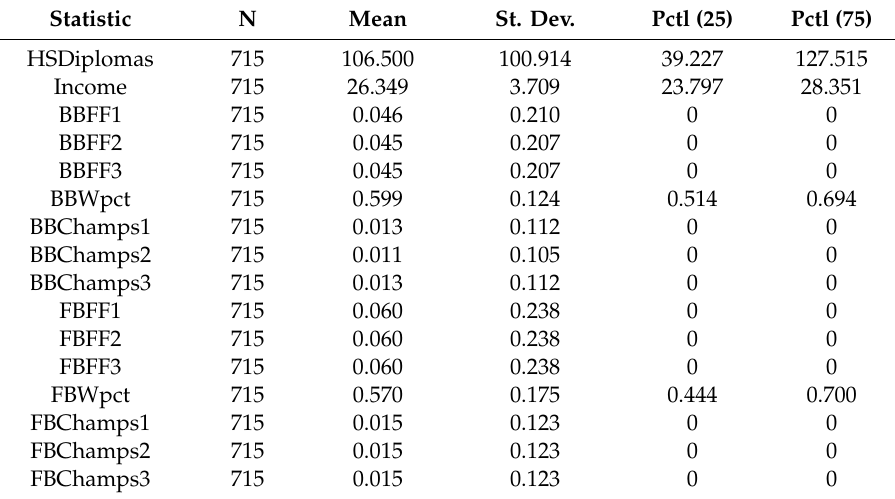
Table 2. Data profile, explanatory